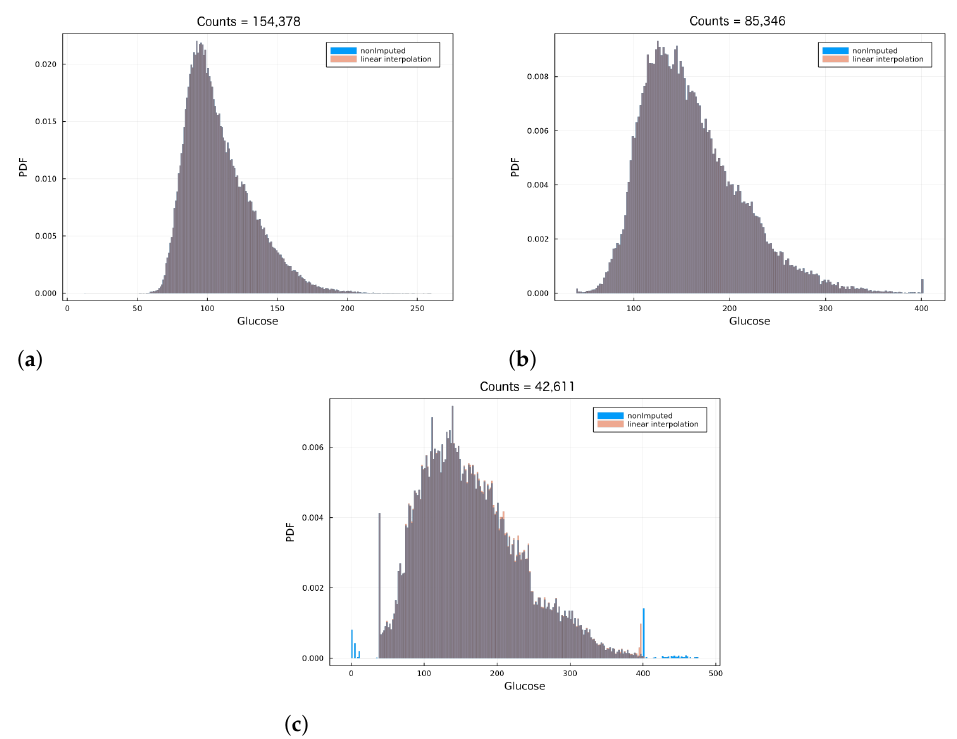
Figure 1. CGM normalized histograms before and after data imputation. Each panel corresponds to a different individual in the OpenAPS Data Commons. Each panel shows the CGM data before data imputation in blue, and after data imputation in red. The overlap between the two histograms in each panel suggests that the linear interpolation (proposed in Equation (2)) has little to no effect in changing the data structure. Notice the skewness in the histograms typical of CGM data. Panels ( a ), ( b ) and ( c ) correspond to 154,378, 85,346 and 46,611 glucose measurements,